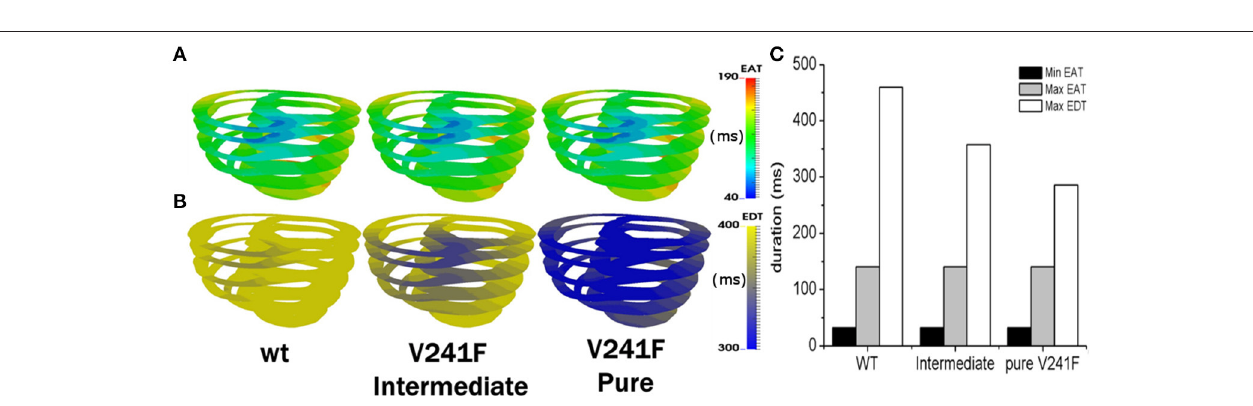
FIGURE 3 | Snapshots of transmural distribution of membrane potential during one cycle of sinus pacing. (A) WT, (B) V241F Intermediate, (C) V241F Pure conditions in the 3D ventricular tissue model.